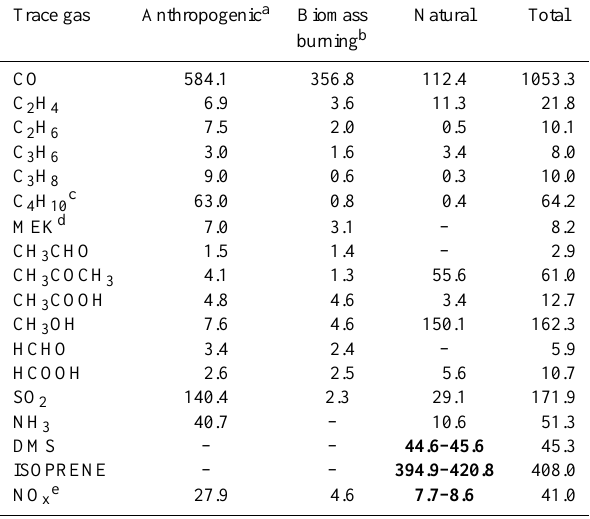
Table 1. Global gas emissions for the year 2005 in Tgyr − 1 . In bold are the emissions calculated on-line by the submodels ONLEM or AIRSEA (maximum and minimum) during the 2005-2008 period.